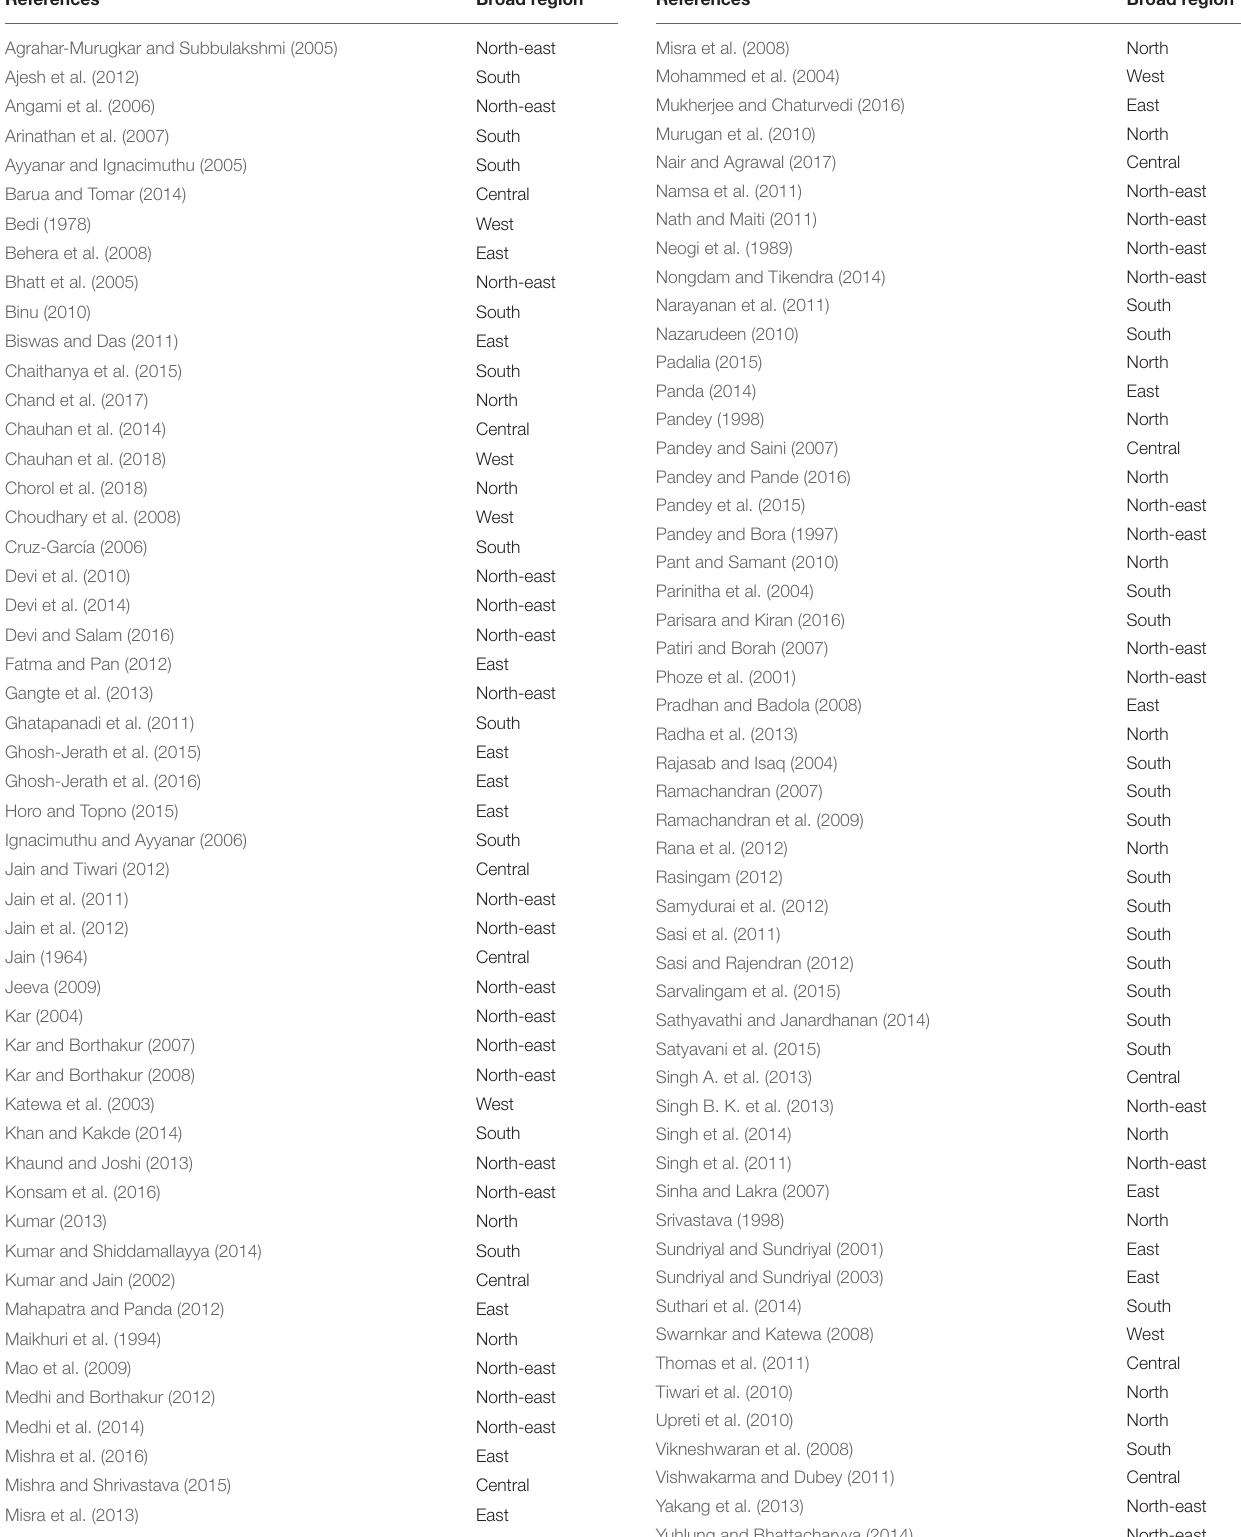
TABLE 1 | The list of studies and their broadly studied